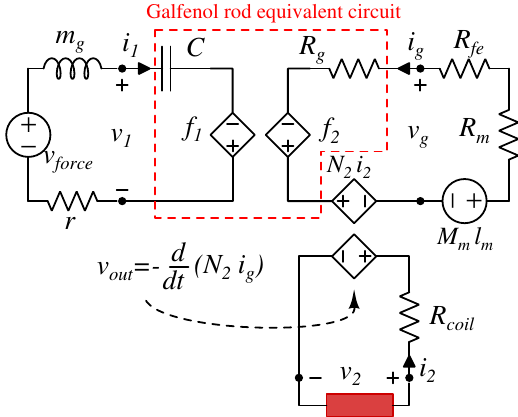
v g ) and f = R g S g · m ( v ) . 2 1 , l g l g